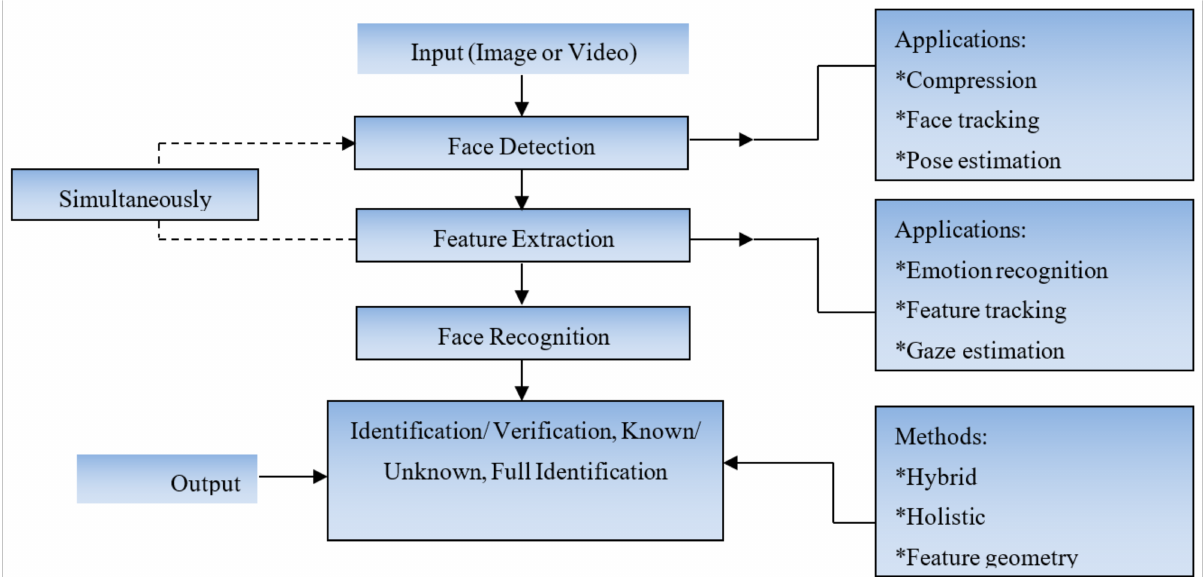
Figure 1. Steps involved in identification and